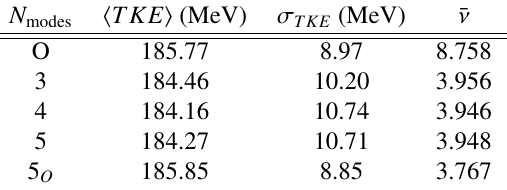
Mode w A σ d min d max d dec S2